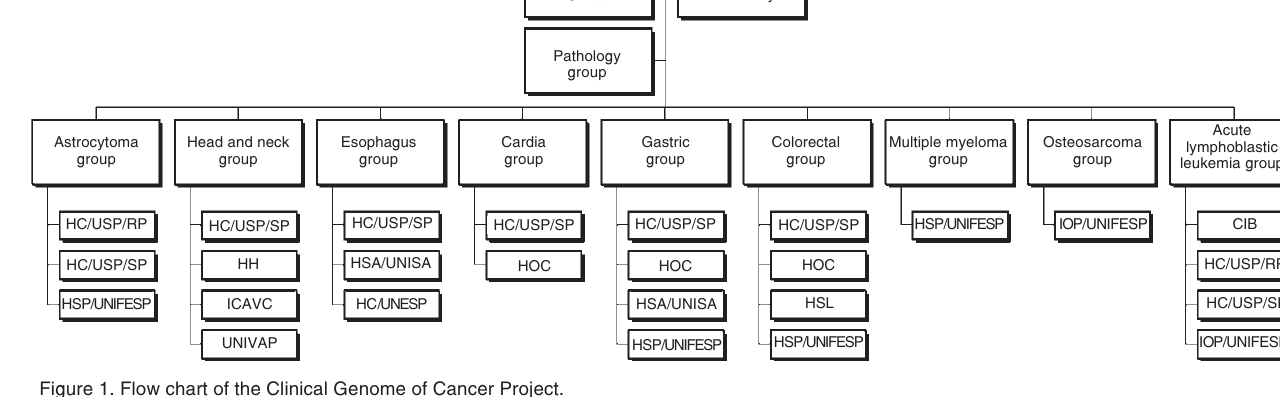
Figure 1. Flow chart of the Clinical Genome of Cancer Project. Clinical